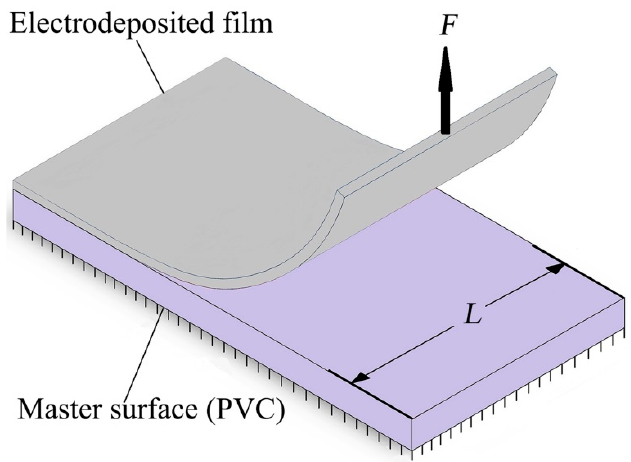
Figure 2. Schematic illustration of release test.